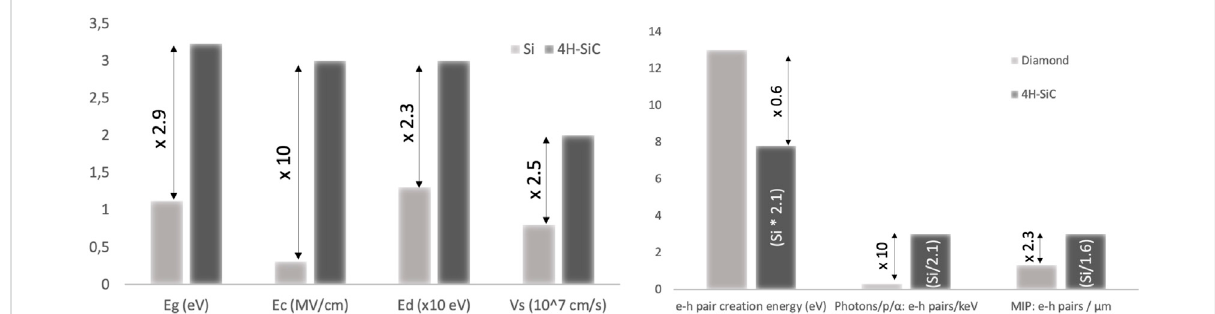
FIGURE 1 SomeSiCpropertiesrelevantforitsuseasdetectionmaterialcomparedtoSi(left)anddiamond(right).HighSchottky/pn barriers,lowthermally generated currents, and visible-light blindness are all results ofa wide bandgap ( E g ).The high critical fi eld ( E c )implies:high bias voltage and no guard rings. High electron saturation velocity ( v s ) means fast signals, short charge transit time, and low charge trapping probability. An high atom displacement energy ( E d ) is synonymous of a potential radiation hardness. Finally, a large number of electon-hole (e-h) pairs produced per unit of energy/path is a prerequisite for high detector